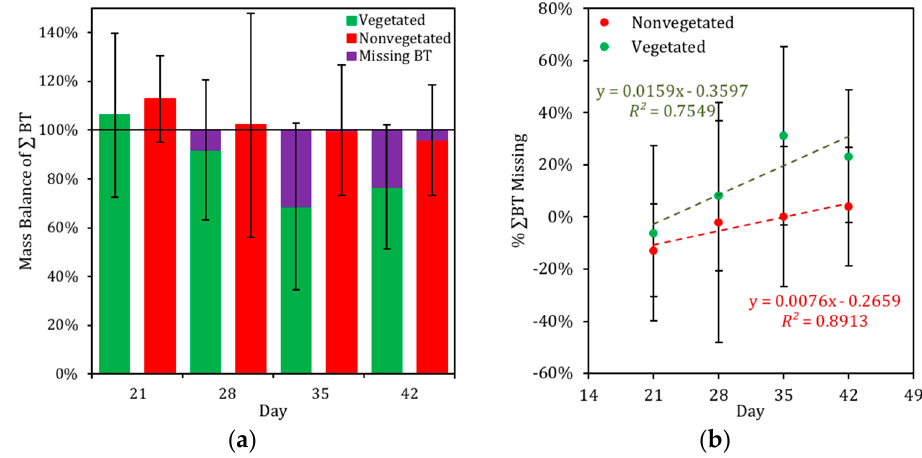
Figure 8. ( a ) Mass balance of BT and metabolite GBT in the vegetated (green) and nonvegetated (red) mesocosms over the period of extended monitoring ( t = 21–42 days). Percent BT missing is calculated based off the total BT and GBT detected in the mesocosms and the expected BT based off the background concentrations of BT and the total mass of BT added during the storm events. ( b ) Linear regression of the percent BT missing is plotted for the vegetated (green) and nonvegetated (red) biofilter mesocosms. Equations of best fit and R-squared values are provided. Error bars represent one standard deviation ( n = 3).